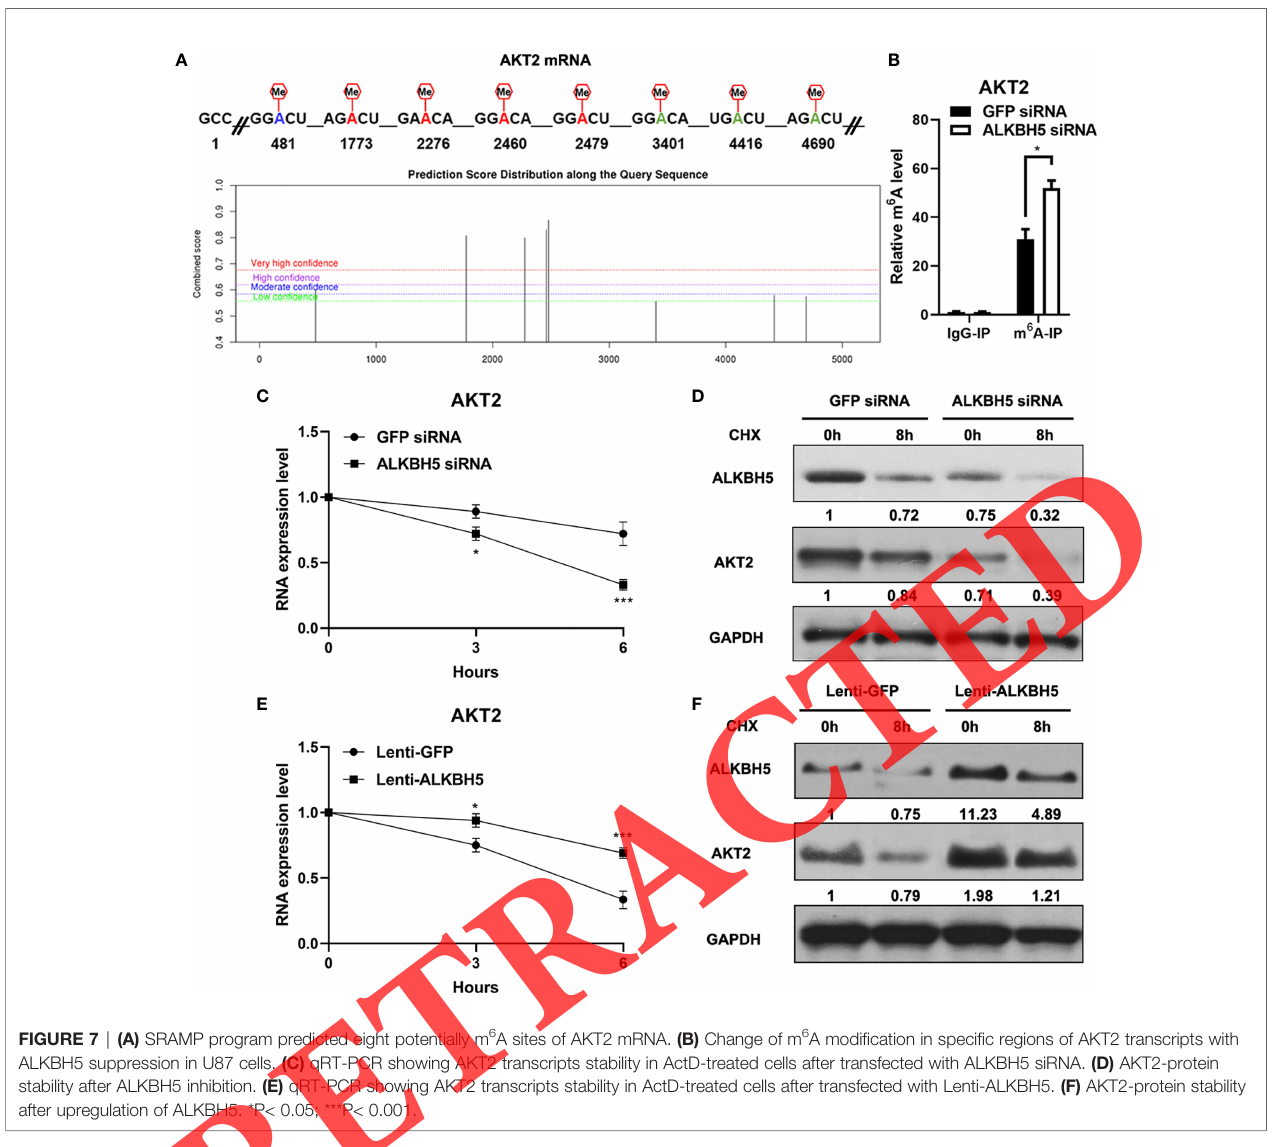
FIGURE 7 | (A) SRAMP program predicted eight potentially m 6 A sites of AKT2 mRNA. (B) Change of m 6 A modi fi cation in speci fi c regions of AKT2 transcripts with ALKBH5 suppression in U87 cells. (C) qRT-PCR showing AKT2 transcripts stability in ActD-treated cells after transfected with ALKBH5 siRNA. (D) AKT2-protein stability after ALKBH5 inhibition. (E) qRT-PCR showing AKT2 transcripts stability in ActD-treated cells after transfected with Lenti-ALKBH5. (F) AKT2-protein stability after upregulation of ALKBH5. *P< 0.05; ***P<